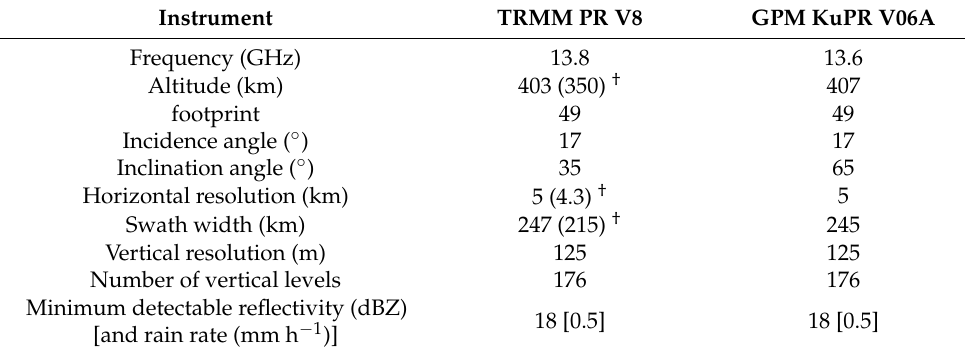
Table 1. Main nominal specifications of the TRMM_PR V8 and GPM_KuPR